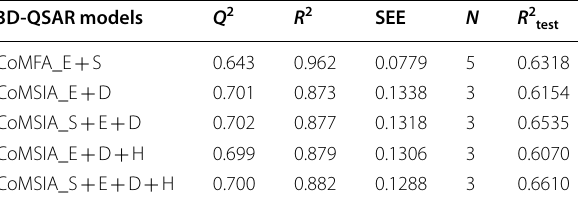
contributions for the studied dataset. The steric and electrostatic contour maps of the CoMFA_ES model for compound 4 are shown in Fig. 7A, B, respectively. The green and yellow contour maps represent the steric interactions, while the red and blue contours signify electrostatic interactions. The CoMFA contour maps